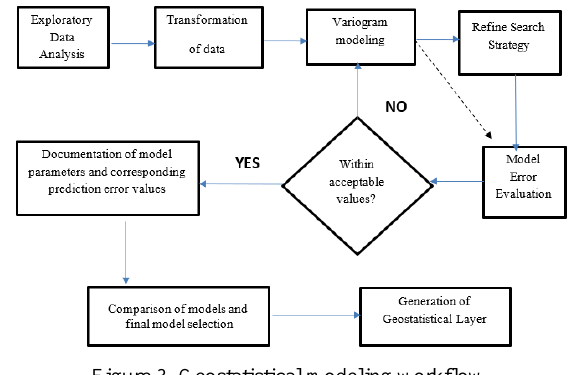
Figure 3. Geostatistical modeling